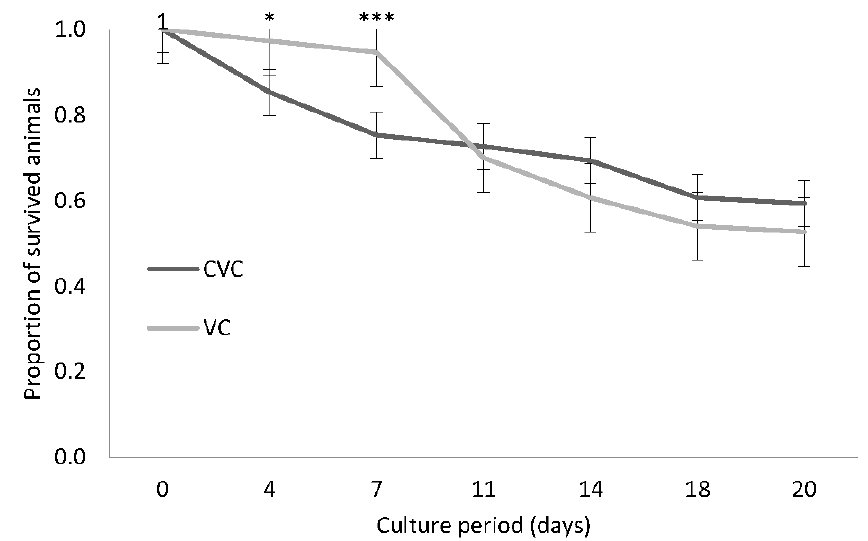
Figure 4. Experiment 2. Proportion of surviving Artemia cultured in Lake Bunyampaka saline water at 30 g L − 1 for 20 days. Values are presented as means ± SE. ( n = 3), * p < 0.05, ** p < 0.01, *** p < 0.001, **** p < 0.0001, ***** p < 0.00001, ****** p < 0.000001 vs. the corresponding control group. VC: Vinh Chau, CVC: Control for Vinh Chau.